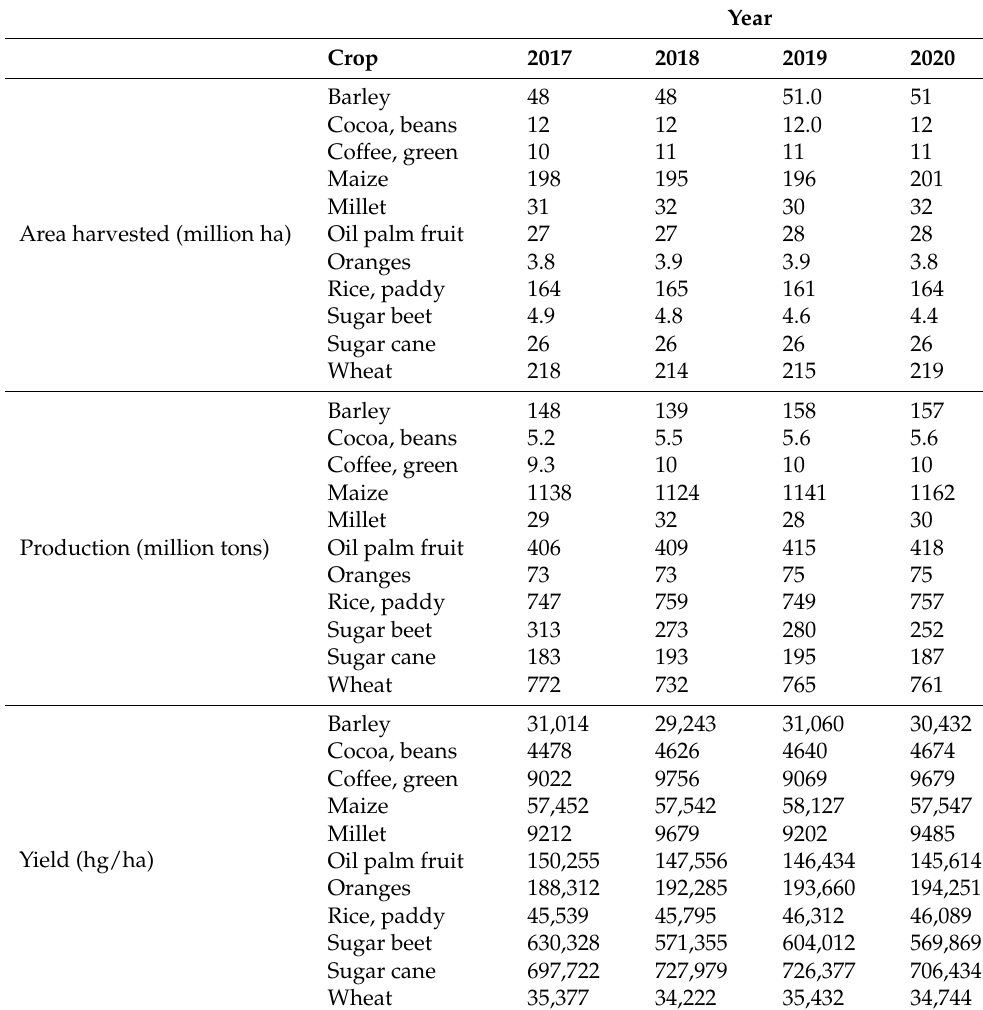
Table 1. World’s total production and yield based on area harvested for various agro-industrial crops in year 2017 to 2020